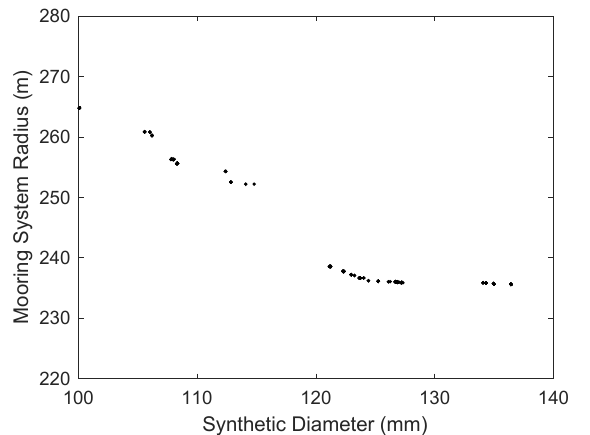
Figure 12. Mooring Radius vs. Chain Diameter for Designs on the Pareto-optimal Front.